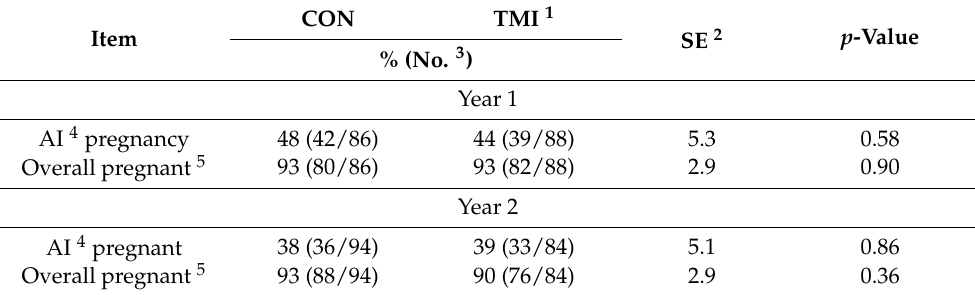
Table 3. Comparison of trace mineral injection (TMI) or not (CON) on reproductive performance of cows. Item